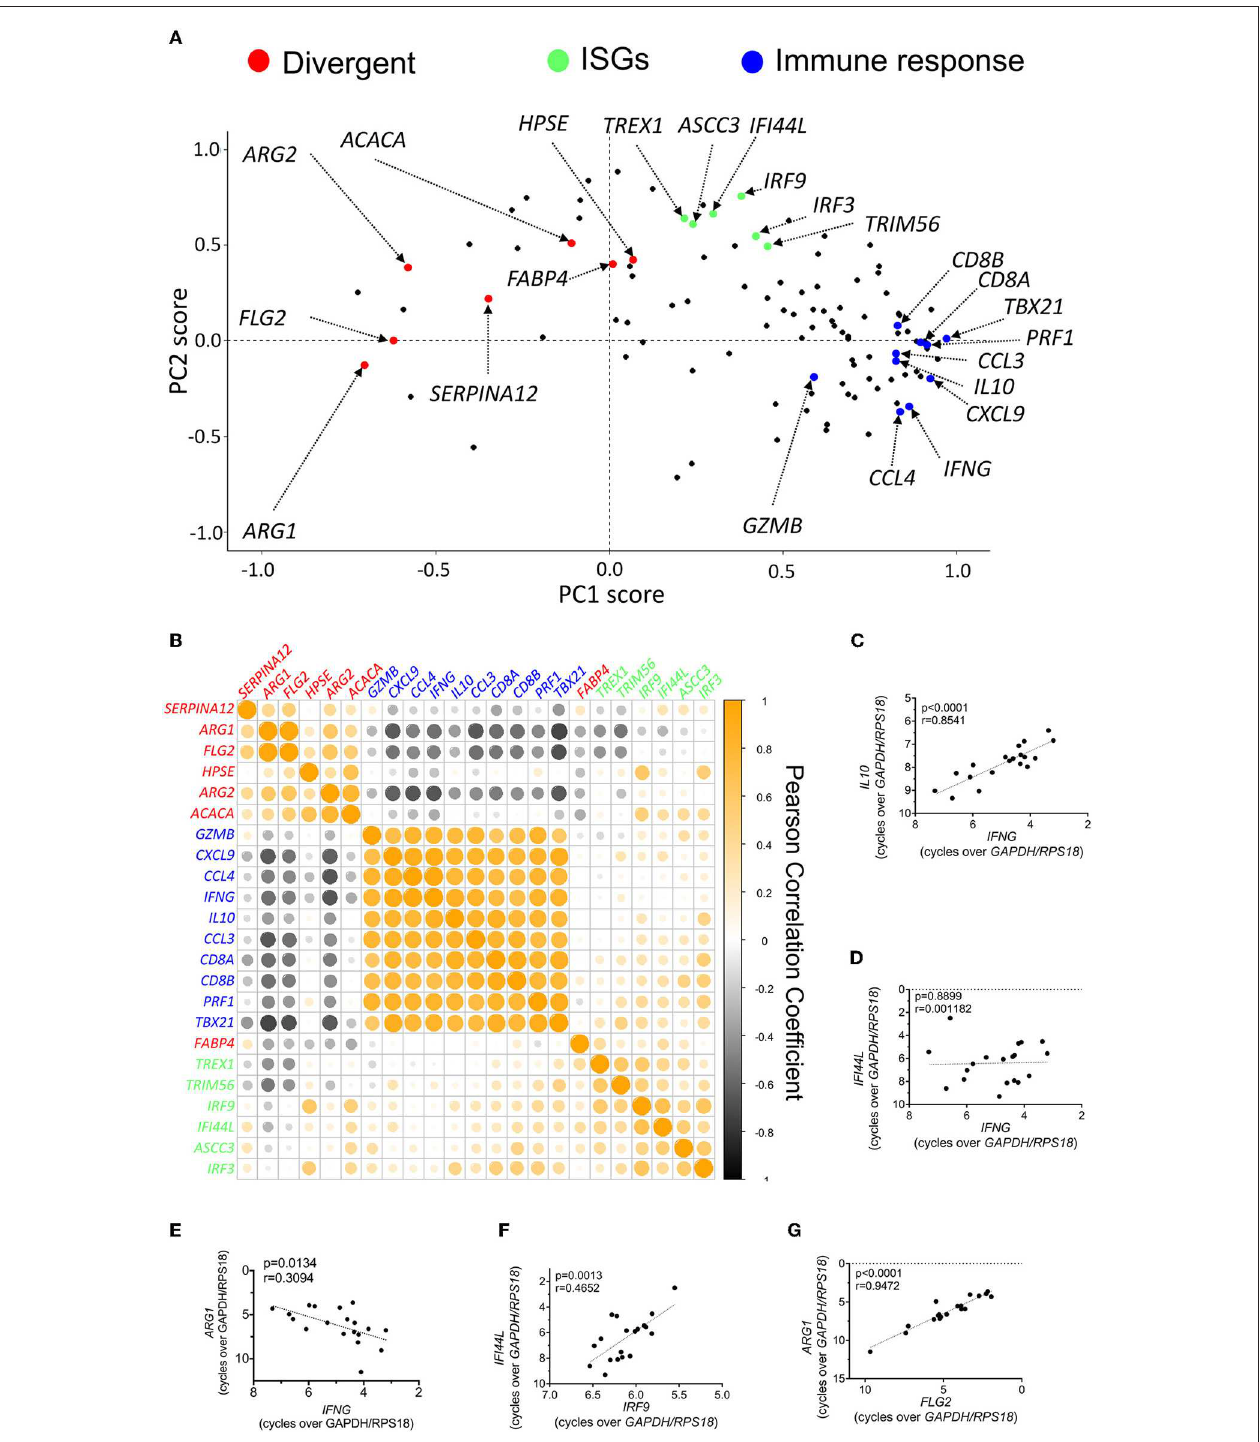
FIGURE 2 | Induction of a pro-inflammatory signature in CL skin is associated with a dampened expression of genes involved in epidermal integrity and arginine and fatty acid metabolism. (A) Scores plot from PCA of skin biopsies from CL patients showing the PCA scores for each of the 111 differentially-expressed genes. Certain groups of genes are highlighted due to their comparable PCA scores and functional relationship. (B) Clustered heatmap of Pearson correlation coefficients of the expression levels for the genes highlighted in Figure 4A in infected skin biopsies. (C–G) Pearson correlation of the expression levels of selected pairs of genes from Figure 4B across infected biopsies; (C) IL10 vs. IFNG ; (D) IFI44L vs. IFNG ; (E) ARG1 vs. IFNG ; (F) IFI44L vs. IRF9 ; (G) ARG1 vs. FLG2 .